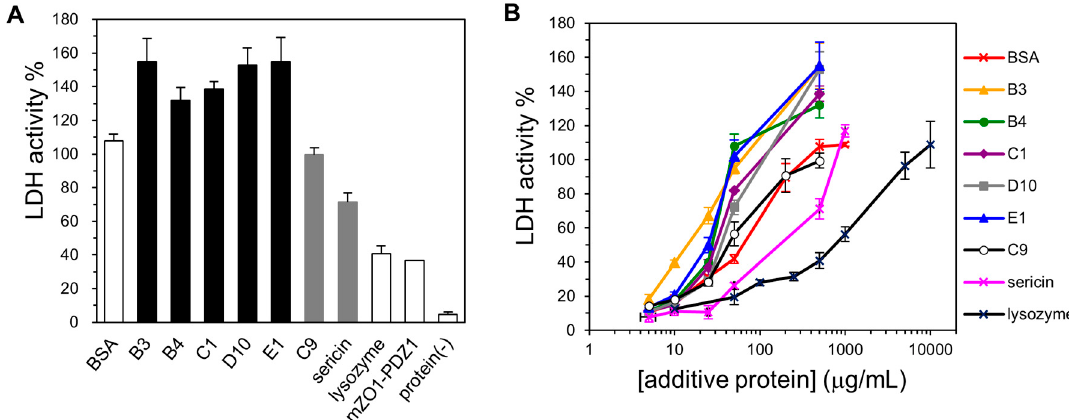
Figure 3. Cryoprotective activity of human genome-derived IDPs and control proteins towards lactate dehydrogenase (LDH). ( A ) LDH activities (final concentration of 50 μ g/mL) after freeze-thawing in the presence of 500 µ g/mL indicated additive protein. The LDH activity of the untreated sample was set to 100%. IDPs and “partial” IDPs are colored as black and gray, respectively. Protein (-) indicates LDH activity without cryoprotectant; ( B ) LDH activities after freeze-thawing with the given additive protein at various concentrations. Error bars indicate the standard deviation of triplicate measurements.